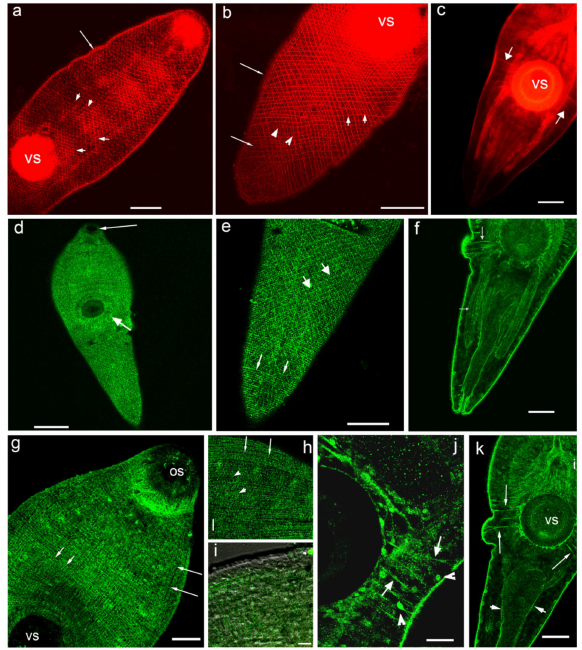
Figure 2. Histochemical staining of the body musculature with phalloidin (red, ( a – c )) and immunore- activity to 5-HT 7 serotonin receptor (green, ( d – k )) in metacercariae larvae of Opisthorchis felineus. ( a , b )—phalloidin staining of body wall musculature in the anterior ( a ) and posterior ( b ) body parts of O. felineus , the longitudinal (long arrows), diagonal (short arrows) and circular (arrowheads) muscle fibres, vs—the ventral sucker; ( c )—muscle fibres extending from the body wall to the ventral sucker (short thick arrows), vs— ventral sucker; ( d )—staining to serotonin receptor (5-HT 7 -IR) in the body wall muscles of O. felineus , overview, os— the oral sucker (long arrow), vs—the ventral sucker (short arrow); ( e )—posterior body region, the pattern of 5-HT 7 -IR shows the circular (thin arrows) and diagonal (thick arrows) muscle fibres; ( f )—5-HT 7 -IR in the muscle fibres extending from the body wall to the ventral sucker and in the longitudinal muscles of the intestine (arrows); ( g )—the body wall musculature of the anterior region of the body, stained with 5-HT 7 -IR, the longitudinal (long arrows) and circular (short arrows) filaments are indicated, part of the oral sucker musculature (os) is visible; ( h , i )—more detailed views on the 5-HT 7 -IR elements along the body muscles: ( h )—the longitudinal (long arrows) and diagonal (short arrows) muscle fibres are indicated; ( i )—punctate pattern of 5-HT 7 -IR along the circular muscle fibres (arrows), confocal and transmission light mi- croscopy; ( j )—5-HT 7 immunoreactivity in muscle fibres running from the body wall to the ventral sucker (arrows) and in the round structures along the body margin (arrowheads); ( k )—5-HT 7 -IR in the posterior body region, the muscle fibres running from the body wall to the ventral sucker (long arrows) and the longitudinal muscles of the excretory bladder (short arrows), vs—ventral